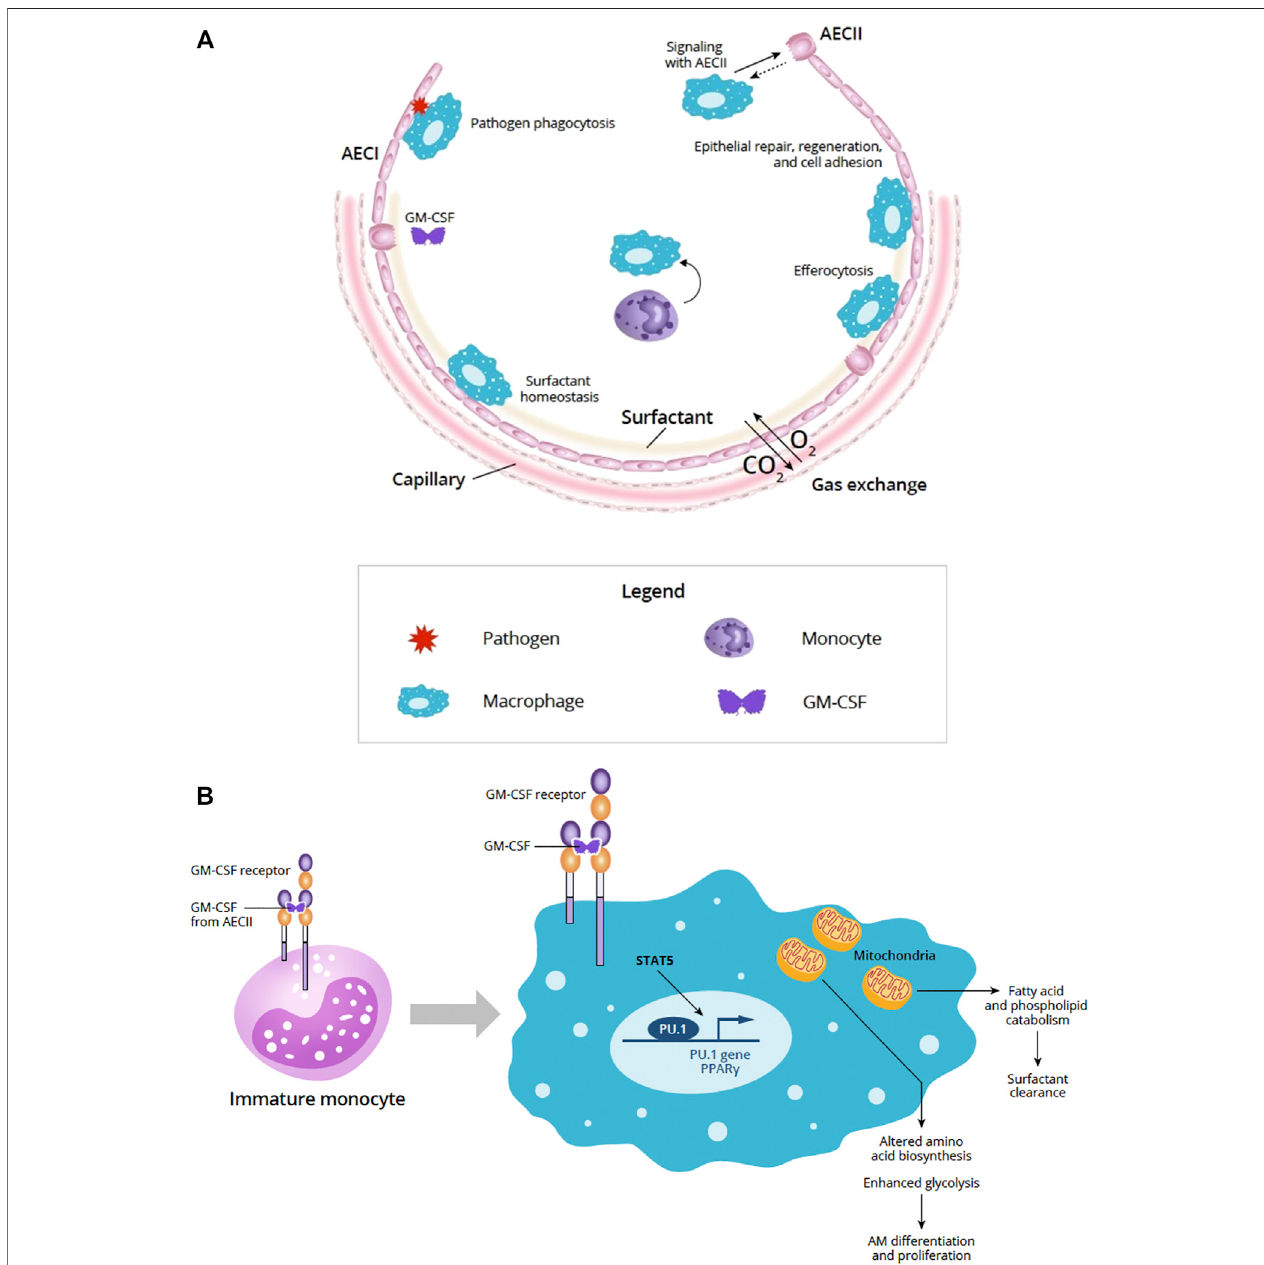
FIGURE1|(A) Overviewofthealveolusunderhomeostaticconditions(AdaptedfromGuillotetal.,2013).Thealveolarepitheliumisimportantforgasexchangeand protection from pathogens via the physical epithelial barrier and phagocytosis. Alveolar homeostasis involves the orchestration of multiple cell types including AECI and AECII and AM. Signaling between AECs and AMs is important for epithelial repair, regeneration, and cell adhesion. AECII produce GM-CSF and other cytokines that participate in key homeostatic processes, such as surfactant homeostasis by AM. AM-driven efferocytosis of epithelial or immune cells undergoing apoptosis also helpstomaintainthealveolarenvironment. (B) RoleofGM-CSFinAMmaturationandGM-CSFsignalinginAMandmitochondrialmechanisms.Inimmaturemonocytes, upon binding to its receptor, GM-CSF signaling through JAK2 and STAT5 activates PU.1 transcription factor initiating differentiation into mature AM. In mature macrophages, GM-CSF signaling through JAK2 and STAT5 activates PU.1 and PPAR γ transcription factors and affects the AM transcriptome and metabolism. Effects of these changes in AM mitochondria can result in altered amino acid biosynthesis and enhanced glycolysis needed for AM differentiation and proliferation. AM mitochondrial changes also support fatty acid and phospholipid catabolism required to support surfactant clearance. Abbreviations: AECI, alveolar epithelial cell type I; AECII, alveolarepithelialcelltypeII;AM,alveolarmacrophage; CO 2 ,carbondioxide;DC,dendriticcell;GM-CSF,granulocyte-macrophagecolony-stimulatingfactor;O 2, oxygen; STAT5, signal transducer and activator of transcription 5.